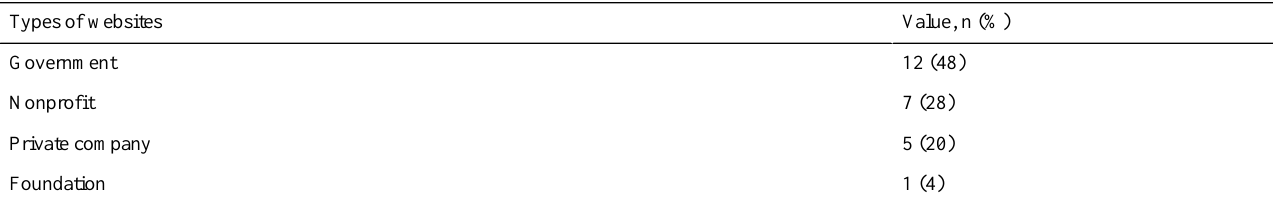
Table 1. Types of websites for distracted driving.